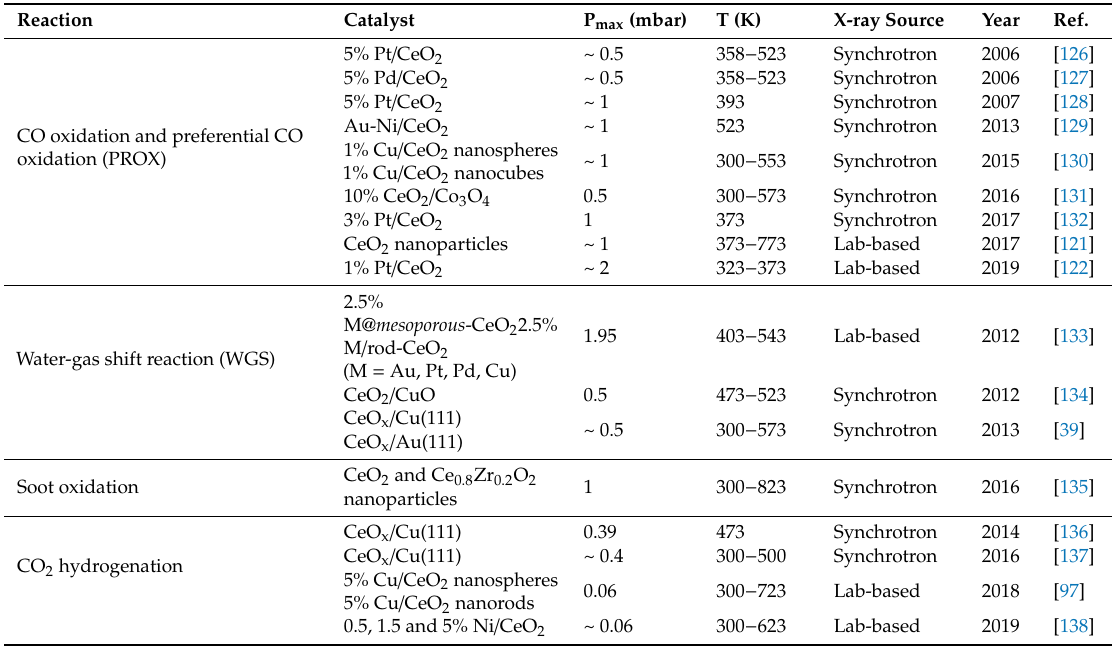
Table 1. Published near ambient pressure X-ray photoelectron spectroscopy (NAP-XPS) investigations of ceria-based catalysts in gas-solid